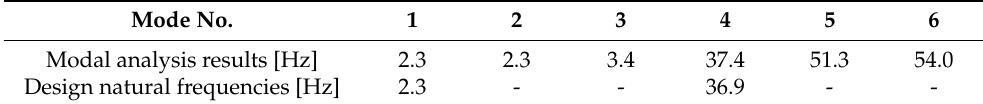
Table 3. Comparison of designed LRB natural modes with analysis results.